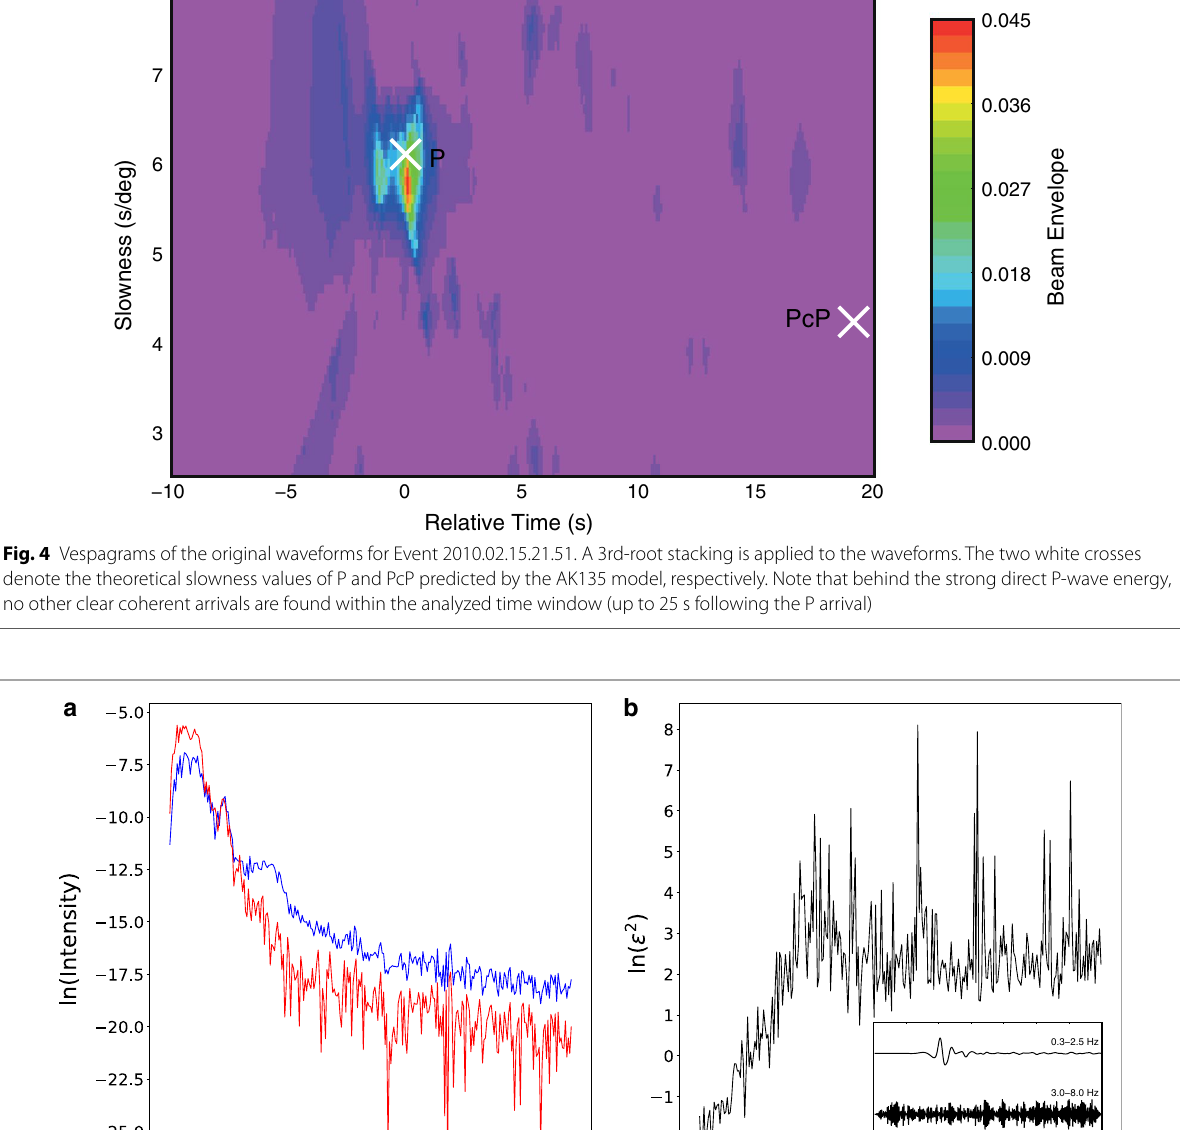
The similar feature of the frequency-dependent ln( ε 2 ) for all the events is presented in Fig. 6. The stacked curve of ln( ε 2 ) is negative ( I f < I c ) below ~1.2 Hz, implying that the low-frequency content of teleseismic wavefield is